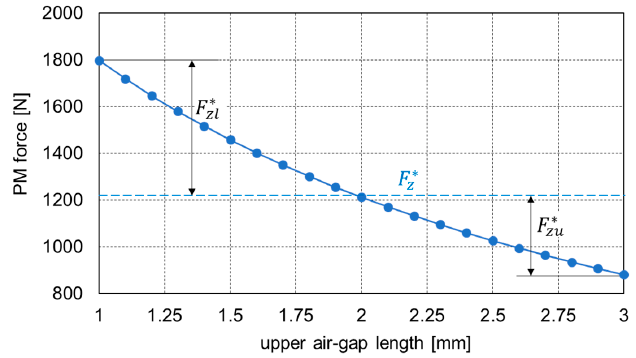
Figure 9. PM axial force F z 0 as a function of the air-gap length g u ; F ∗ zu , 𝐹 (cid:3053)(cid:3039)∗ : force deviations at 𝑔 (cid:3048) , (cid:3040)(cid:3028)(cid:3051) and g u , min .